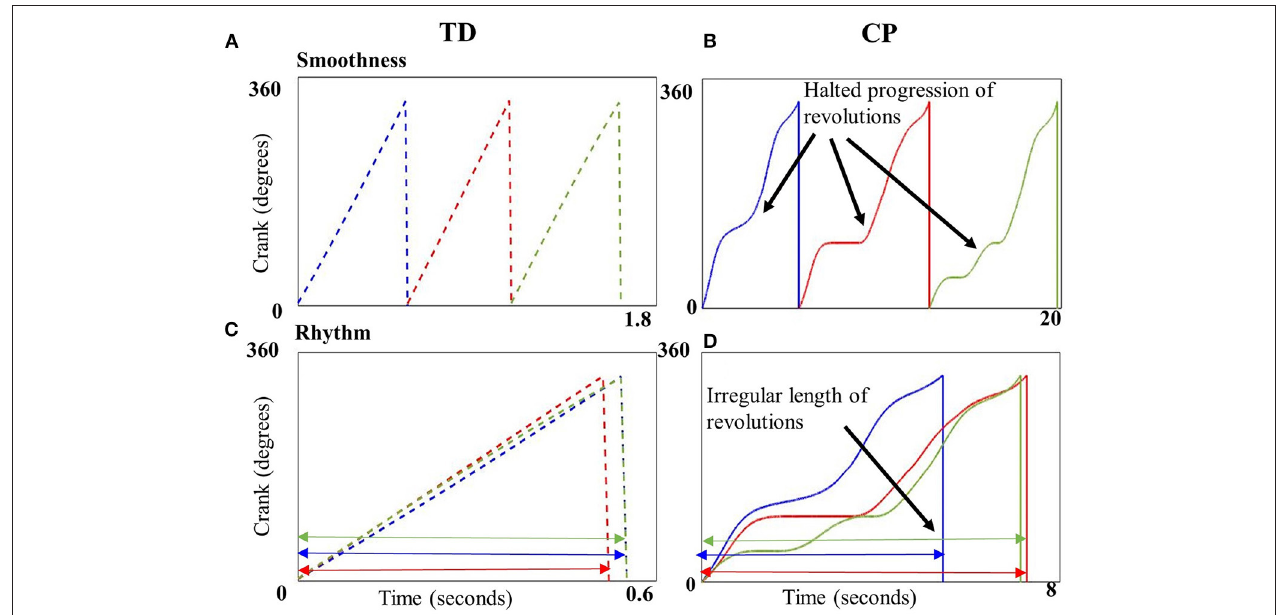
FIGURE 3 | Crank angle plotted against time (seconds) for three example revolutions (blue, red, and green) from a single representative child with typical development (TD) (A,C) and CP (B,D) . Top panels depict the smooth transition from 0 to 360 ◦ in a child with TD (A) vs. the uneven, halted progression in a child with CP (B) . Cycling revolutions are superimposed on each other in the bottom panels to depict rhythmicity, which shows the consistent length of the revolutions in a child with TD (C) , implying better rhythmicity in contrast to the inconsistent length of revolutions in a child with CP (D) implying poor